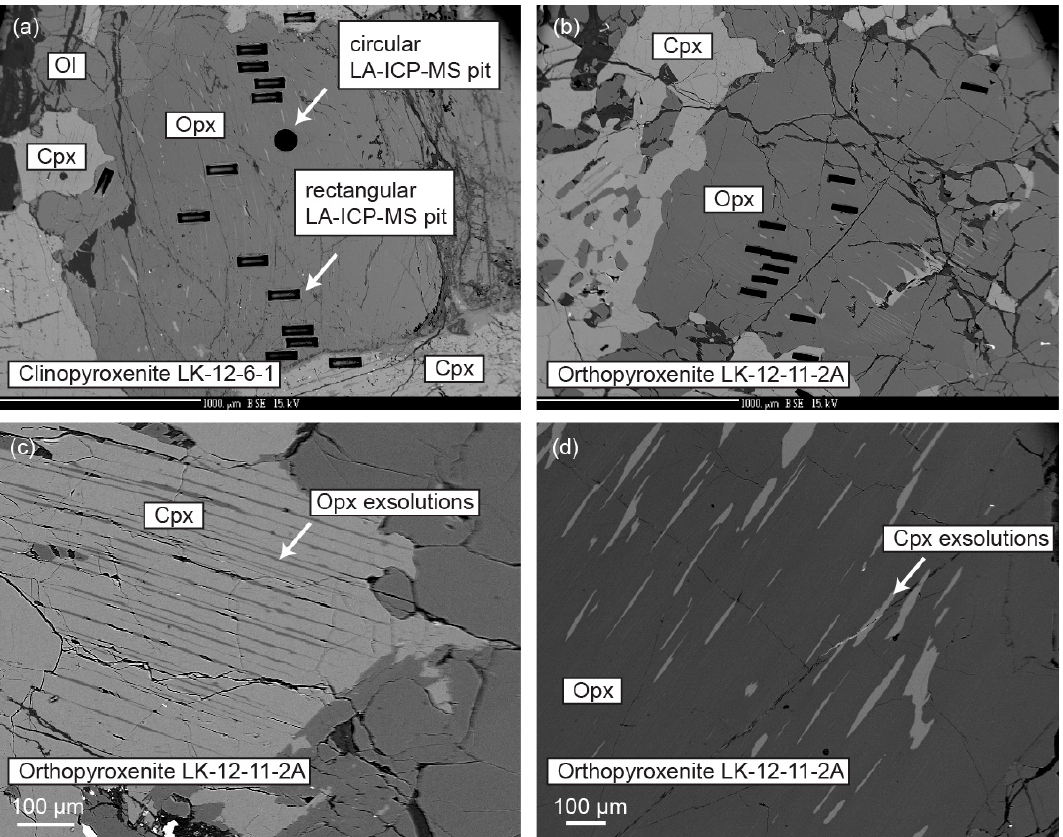
Figure 3. Back-scattered electron photographs of two Josephine pyroxenites. Orthopyroxenes (OPX) and clinopyroxene (CPX) grains in ( a ) clinopyroxenite LK12-6-1 and ( b ) in orthopyroxenite LK11-2A. Minor olivine (OL) is also observed. Exsolutions are usually relatively narrow in CPX ( c ) and wider in OPX ( d ).